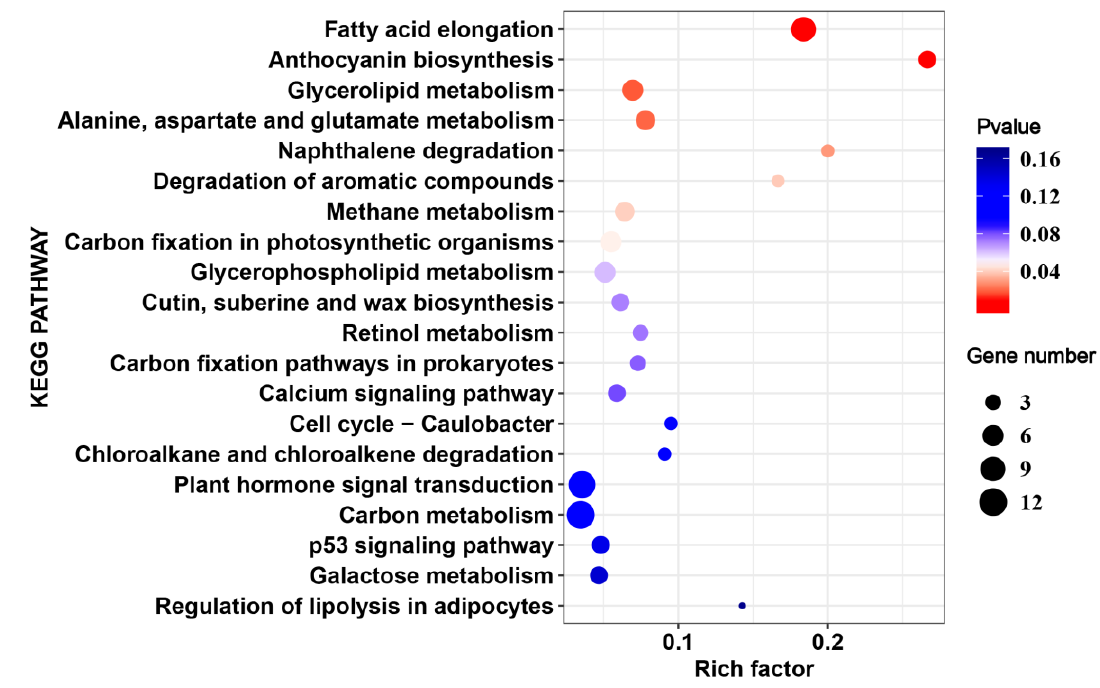
Figure 4. Top 20 enriched pathways for common heat-responsive genes in 17CL30 and 05S180.